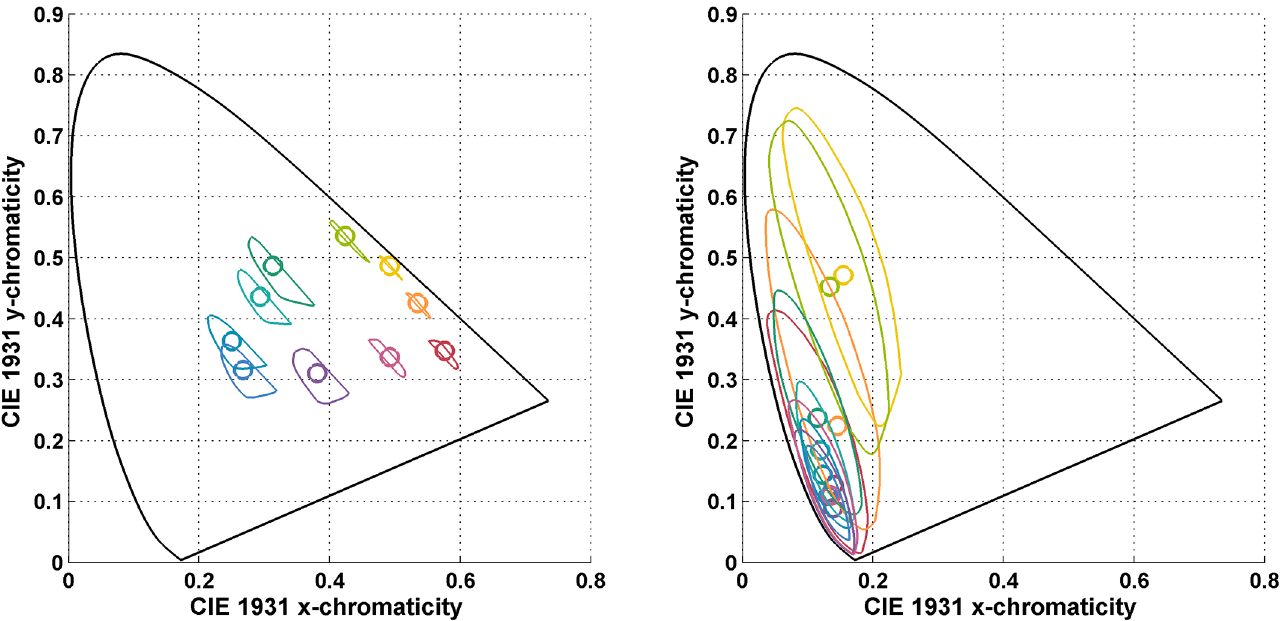
Fig 4. (Left) The chromaticity mismatch area for a shift from the neutral (N) illuminant to the yellow (Y) illuminant. (Right) The chromaticity mismatch area for a shift from the neutral to the blue (B) illuminant. Plots are in the CIE 1931 xy-chromaticity diagram. The circles are the chromaticities of the 10 odd-numbered Munsell papers from Fig 2 (left) under the second illuminant in each case. The closed contours indicate the boundaries of the metamer mismatch areas. The colour of the circles and boundaries of the metamer mismatch areas correspond to one another, and very roughly indicate the colours of the Munsell